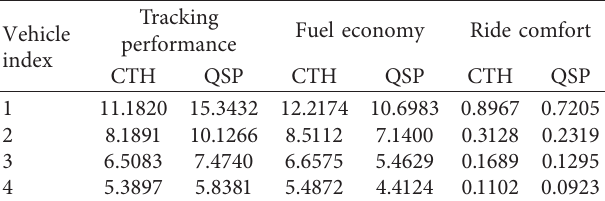
Figure 4: Distances and spacing errors of the platoon with CTHP ( h Table 1: The performance comparison of different spacing